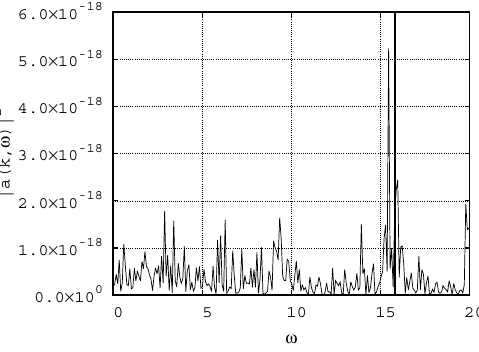
Figure 7. Spectral line of the harmonic k = (0, 250). Both the con- densate and inverse cascade were suppressed.